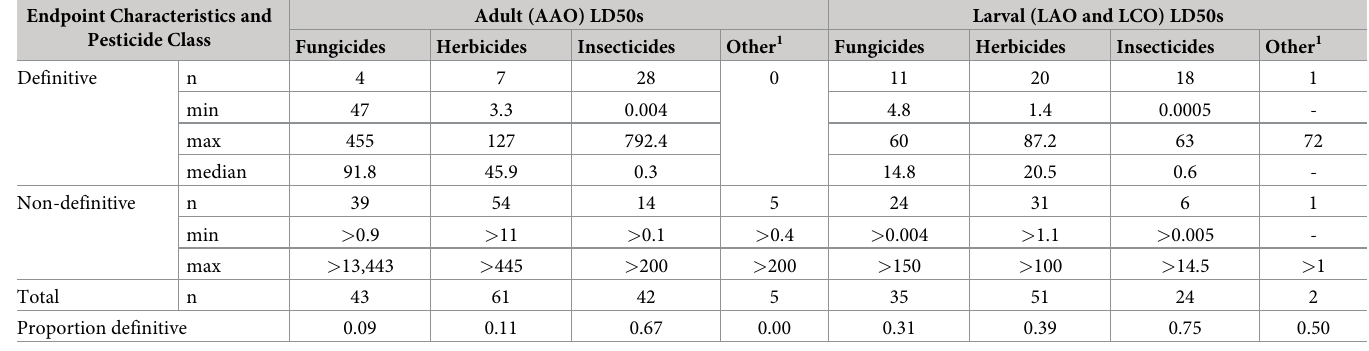
Table 3. Distribution of all available acute toxicity data (LD 50 values) for honey bee ( Apis mellifera ) adults and larvae. AAO- Adult Acute Oral, LAO- Larval Acute Oral, LCO- Larval Chronic